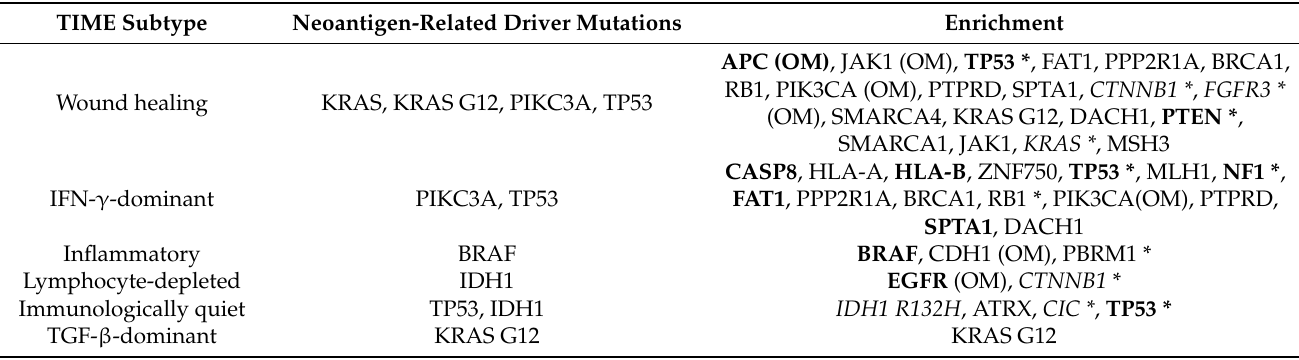
Table 3. Mutations associated with the most common neoantigens and enriched in different TIME subtypes based on TCGA